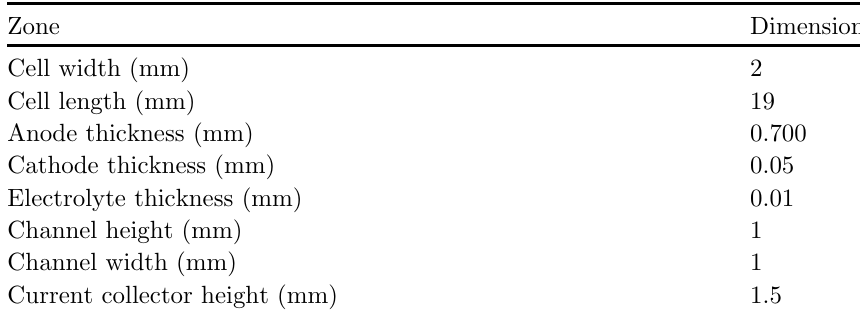
Table 1. Geometrical parameters.